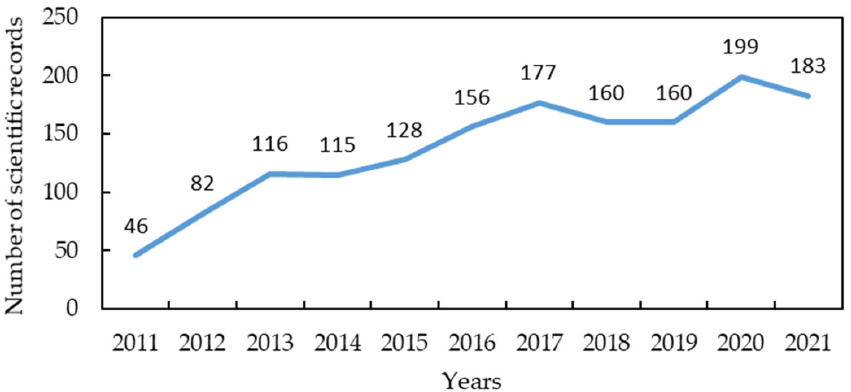
Figure 1. Record of the number of publications/articles in research works related to defined topics via Web of Science for the period 2011–2021. Seaweeds are an attractive feedstock with various advantages: first, their wide avail- ability offers an abundant supply of biomass for use in biogas plants [19]. As a promis- ing feedstock for biogas production, high values of biomethane potential (BMP) have been obtained from the brown seaweed Macrocystis (0.39–0.41 m 3 CH 4 /kg Volatile solids (VS)) [20], the red seaweed Gracilaria (0.28–0.4 m 3 CH 4 /kg VS) [21], these values are comparable to the BMP of terrestrial crops such as sorghum (0.26–0.39 m 3 CH 4 /kg